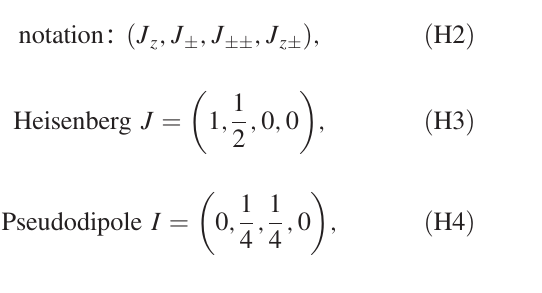
, and f ⃗ γ g ij ij